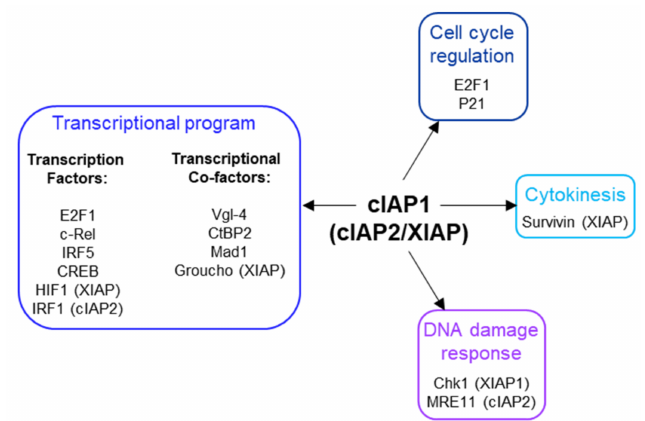
Figure 5. Nuclear partners of cIAP1, cIAP2 and